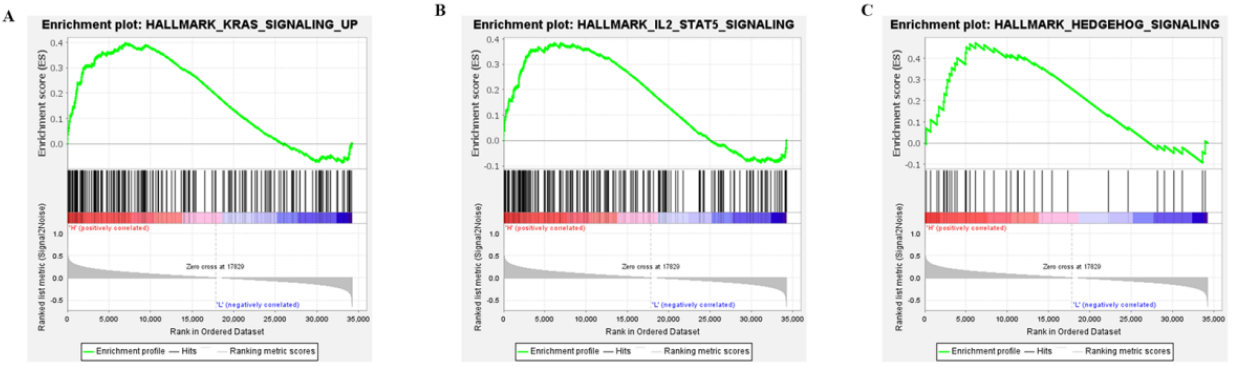
Figure 5. Enrichment plots from the gene set enrichment analysis (GSEA): ( A ) KRAS signaling; ( B ) IL2-STAT5 signaling; ( C ) HEDGEHOG signaling.